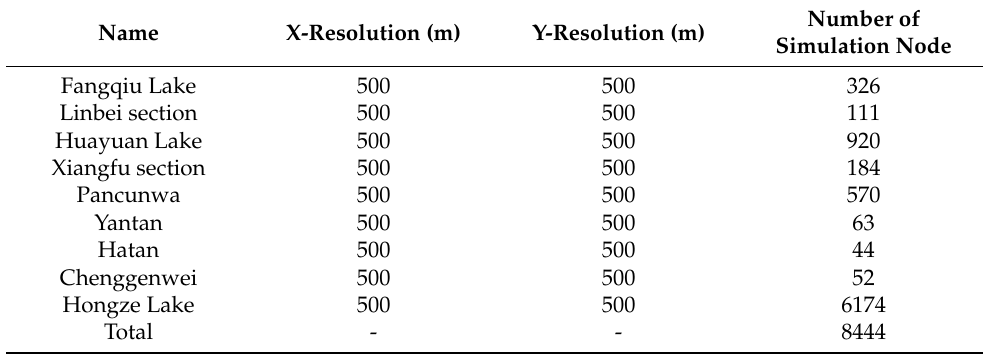
Table 1. Model discretization of the simulation